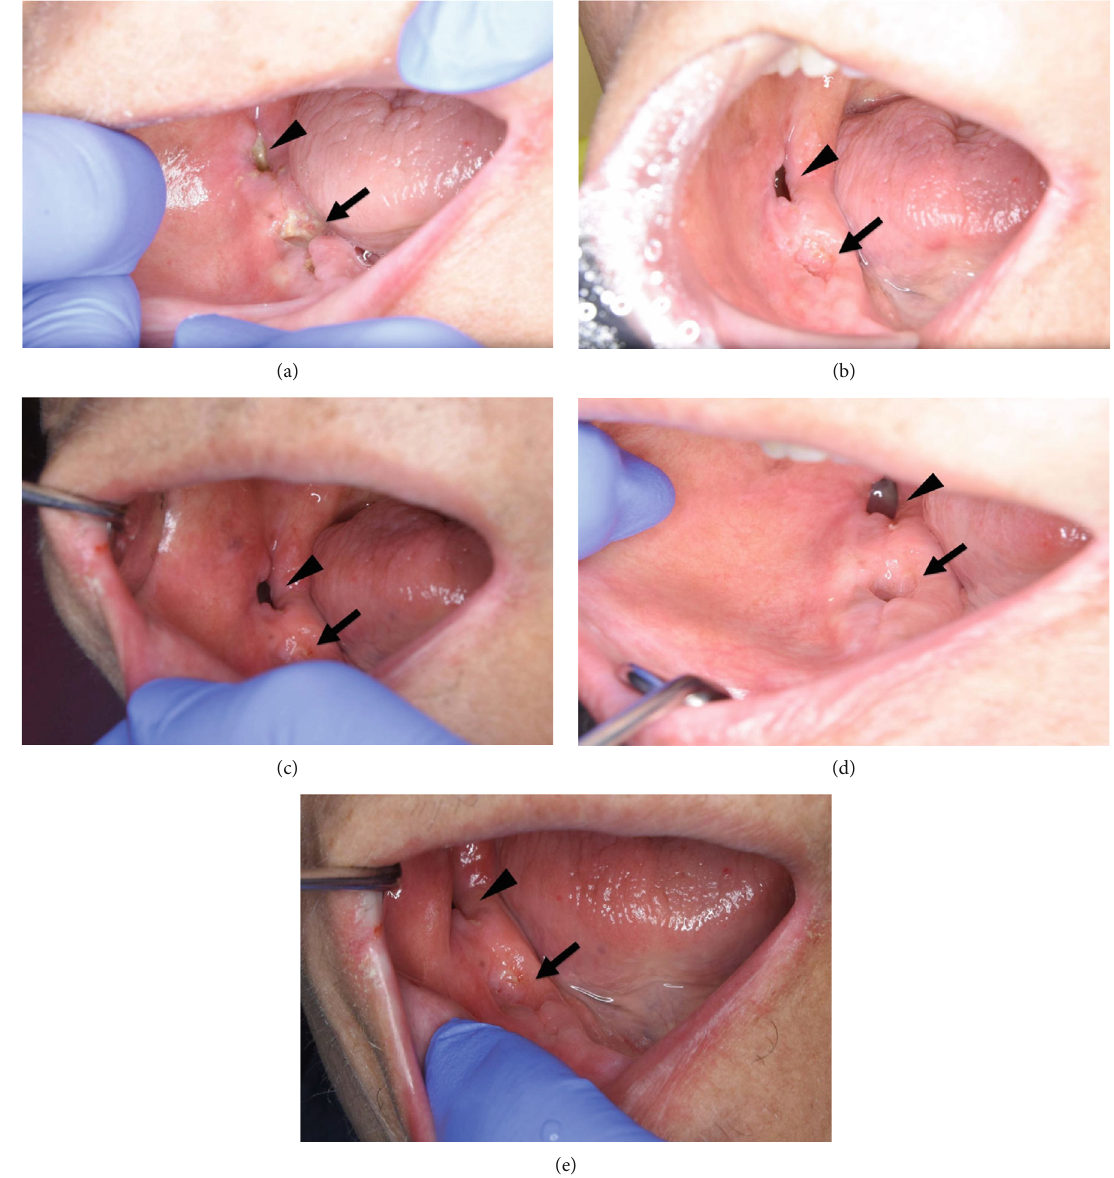
Figure 2: Photographs showing the healing process of the sockets. (a) Bone exposure was noted 23 days after the extractions in each socket (arrow, sockets of the fi rst molar and second premolar; arrowhead, socket of the third molar). (b) Sixty-one days after the extractions, sockets of the fi rst molar and second premolar were mostly covered with soft tissue (arrow), whereas the socket of the third molar was not covered (arrowhead). (c) Seventy- fi ve days after the extractions, sockets of the fi rst molar and second premolar were almost completely covered with soft tissue (arrow), but the socket of the third molar was only slightly covered (arrowhead). (d) One hundred and seventeen days after extractions, sockets of the fi rst molar and second premolar were completely covered with soft tissue (arrow). However, the socket of the third molar was only partially covered (arrowhead). (e). One hundred and thirty days after extraction, the socket of the third molar was almost completely covered with soft tissue